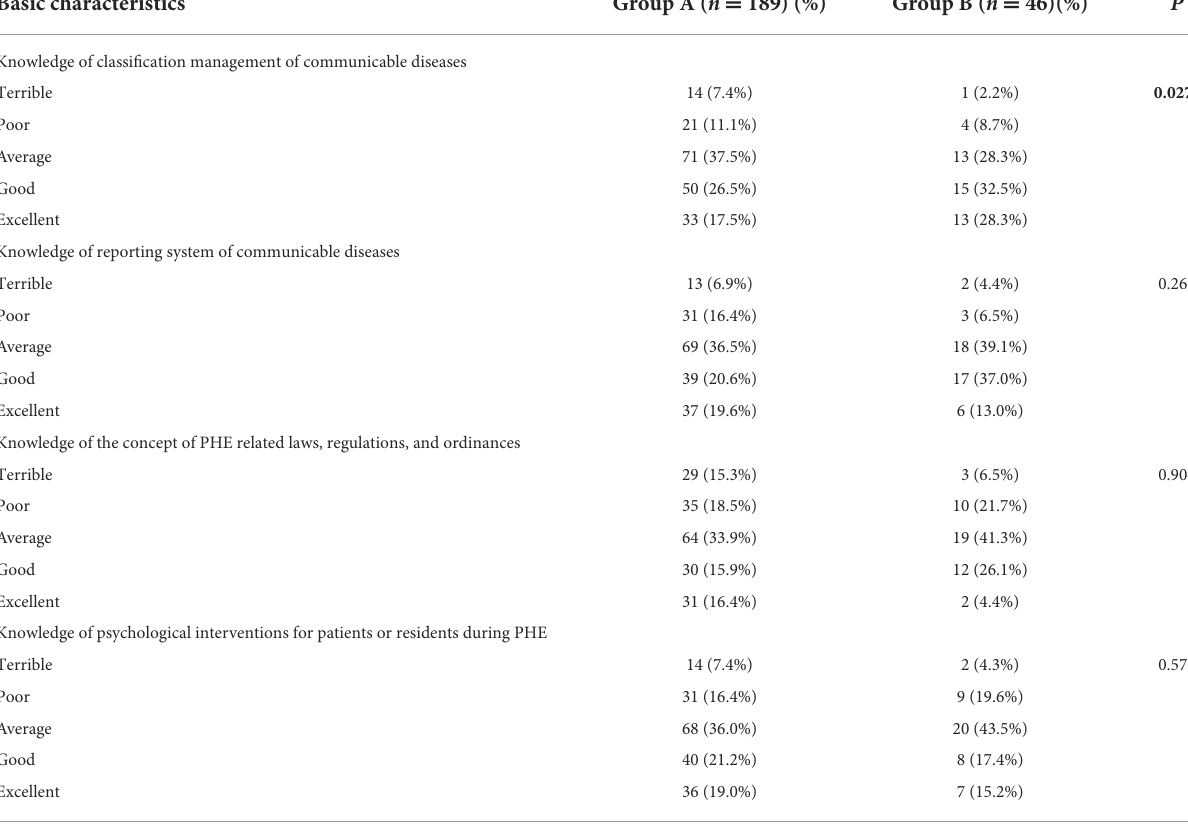
TABLE 5 Comparison of the mastery of public health emergency regulations and psychological intervention abilities between clinical and preventive medical students. Basic